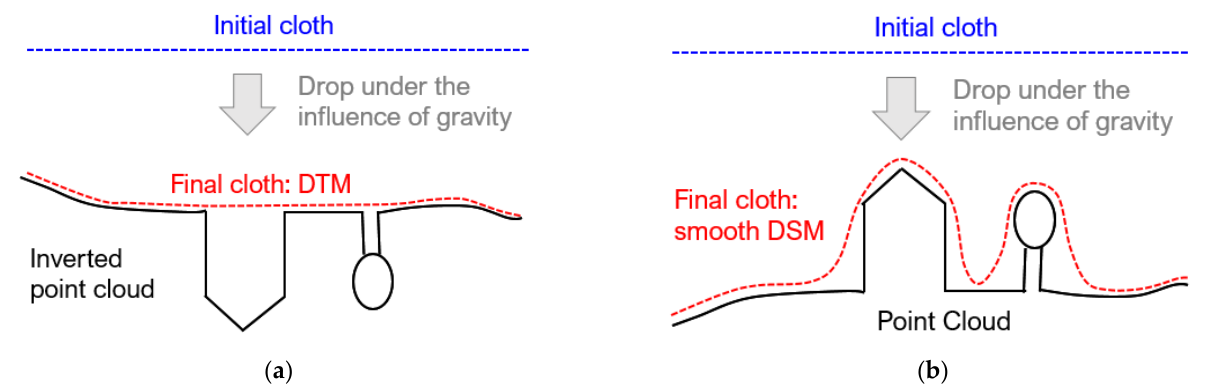
Figure 11. A schematic diagram of ( a ) the original cloth simulation for digital terrain model (DTM) generation and ( b ) proposed approach for smooth DSM generation.